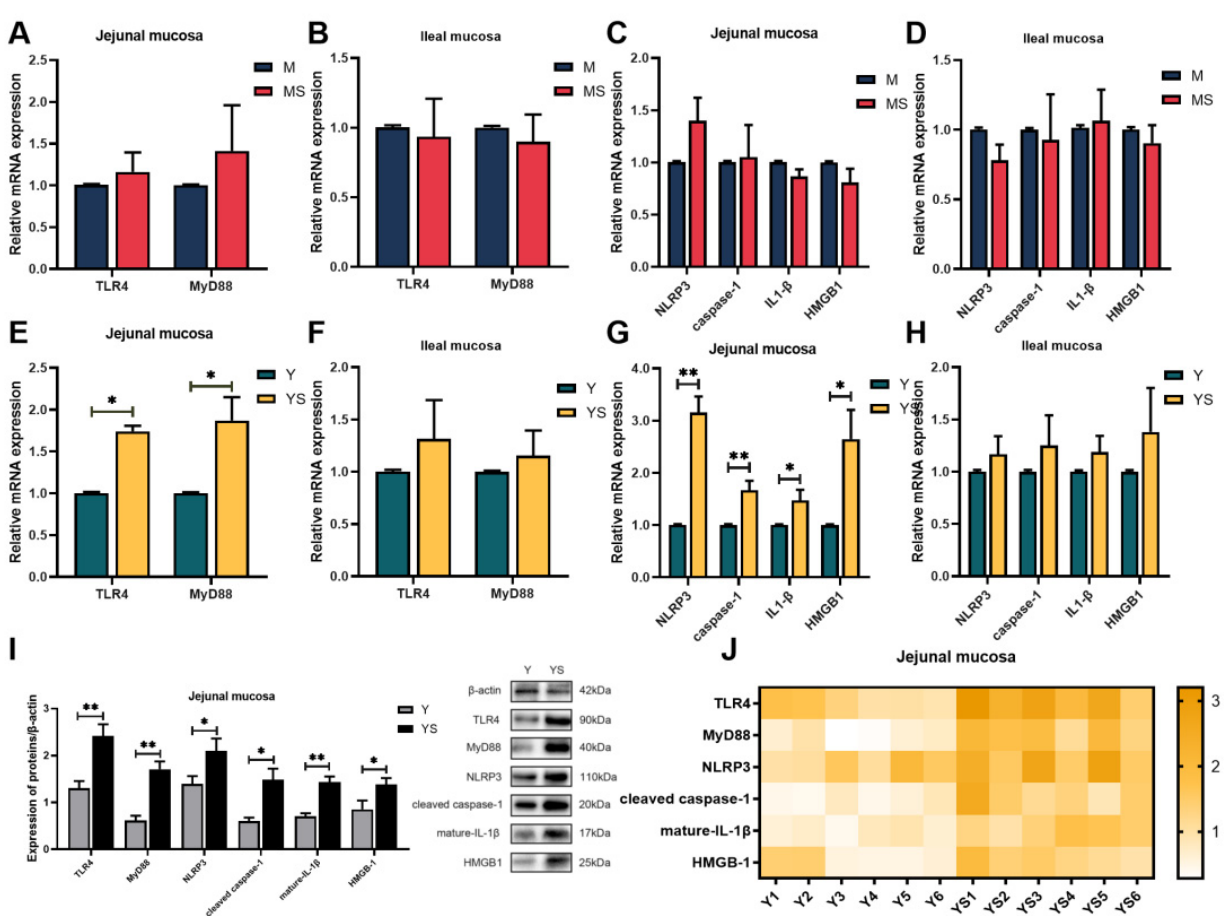
Figure 4. Effects of chronic cold stress on the expression of key genes and proteins in the TLR4/NLRP3 signaling pathway in the intestinal mucosa of pigs. ( A , B ) The mRNA expression of TLR4 and MyD88 in intestinal mucosa of Min pigs (n = 6). ( C , D ) The mRNA expression of key genes of pyroptosis in the intestinal mucosa of Min pigs (n = 6). ( E , F ) The mRNA expression of TLR4 and MyD88 in intestinal mucosa of Yorkshire pigs (n = 6). ( G , H ) The mRNA expression of key genes of pyroptosis in the intestinal mucosa of Yorkshire pigs (n = 6). ( I , J ) The expression of TLR4/NLRP3 signaling pathway-related proteins in the jejunal mucosa of Yorkshire pigs (n = 6). Data are presented as the means ± SEM. * p < 0.05, ** p < 0.01.